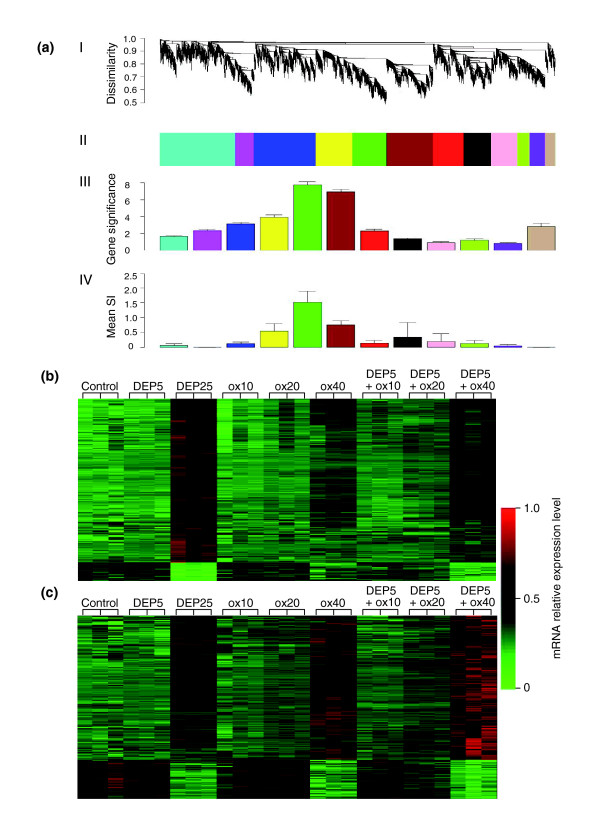
Gene coexpression network analysis. (a) The gene coexpression network. The 3,600 most varying genes were selected to construct a weighted gene coexpression network. I, The average linkage hierarchical clustering tree; II, clustered gene modules represented by different colors; III, gene significance of the individual modules. The green, brown and yellow modules were enriched in significant genes most highly correlated with the treatment conditions (p < 0.0001). Gene significance = -log (p value). IV, The synergistic gene enrichment. The mean synergistic indices (SI) of network genes that were upregulated by DEP, ox-PAPC and the corresponding combinatorial treatment of DEP plus ox-PAPC were calculated for each network module. The green, brown and yellow modules were also enriched in genes synergistically coregulated. Mean SI, mean synergistic index as defined in Materials and methods. (b) Heat map of the green module; (c) Heat map of the brown module. Expression levels of (b) 307 genes and (c) 426 genes are represented in the rows by color coding (green = low expression, red = high expression), in triplicate samples for each treatment condition (columns). Both modules show a clear synergistic/additive pattern where the combinatory treatments exhibited as a whole either a greater level of upregulation (towards red) in 274 genes (b) and 335 genes (c) at the top or downregulation (towards green) in 33 genes (b) and 91 genes (c) at the bottom, compared with the corresponding concentrations of DEP and ox-PAPC alone. Color scale is shown at the right of both heat maps, ranging from 0 (indicated by the green color at the bottom) to 1.0 (indicated by the red color at the top) as a reflection of the level of mRNA expression. DEP5 and DEP25, DEP 5 and 25 μg/ml, respectively; ox10, ox20, ox40: ox-PAPC 10, 20 and 40 μg/ml, respectively; DEP5 + (ox10, ox20 ox40): DEP 5 μg/ml + ox-PAPC 10, 20 and 40 μg/ml respectively.